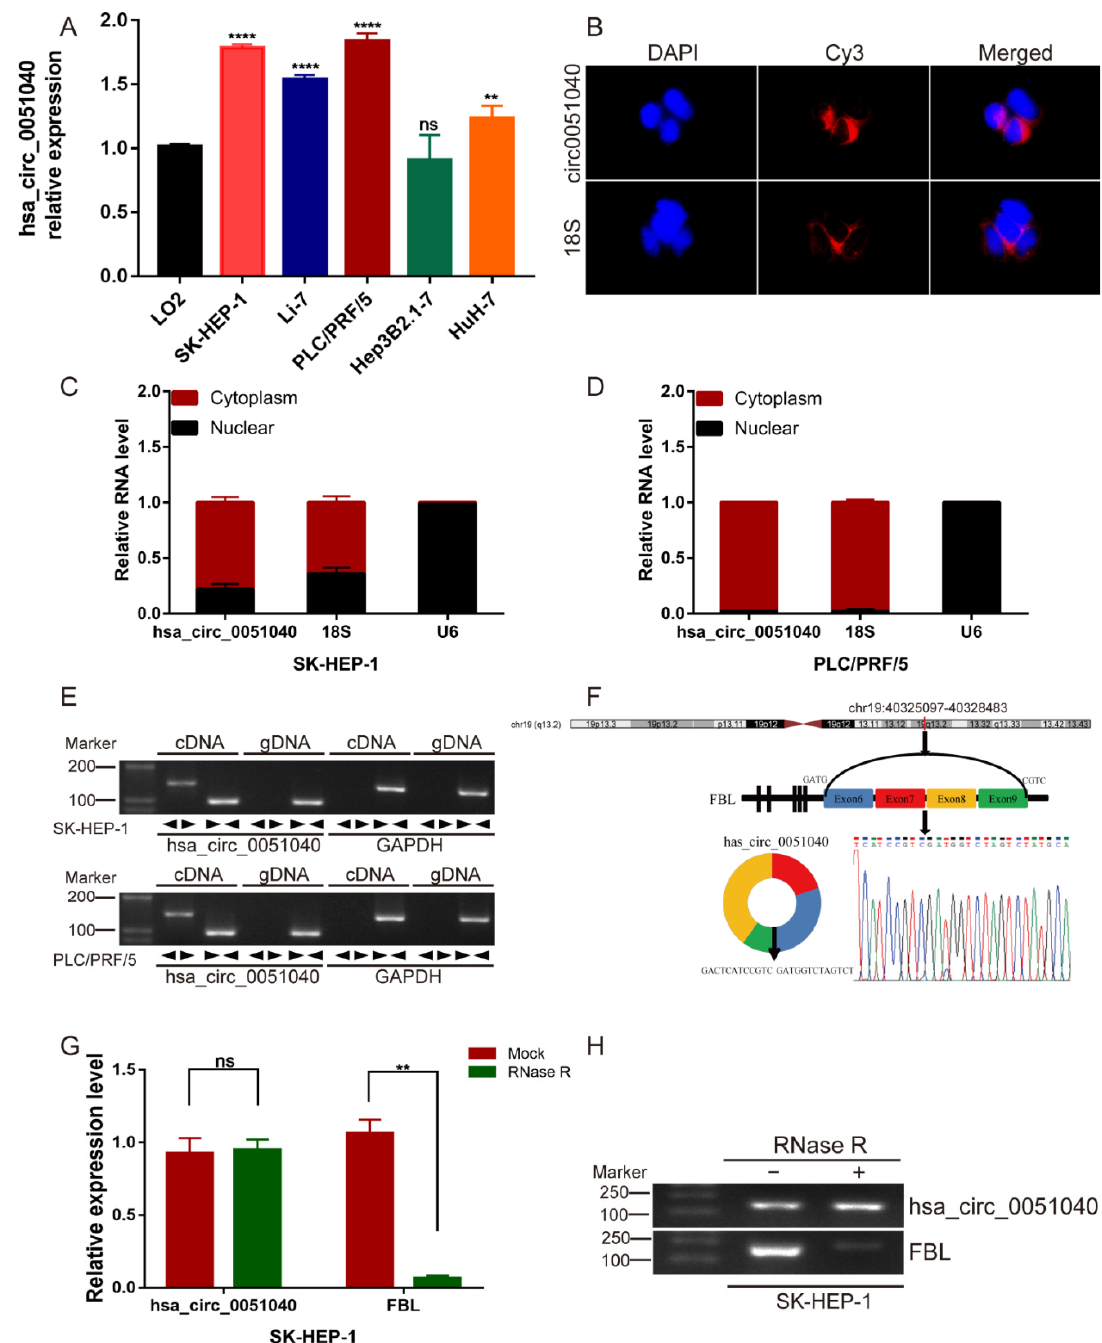
Figure 2. Identification and characteristics of hsa_circ_0051040 in HCC cells. ( A ) The expression levels of hsa_circ_0051040 were detected in HCC cell lines (SK-HEP-1, Li-7, PLC/PRF/5, Hep3B2.1-7 and HuH-7) compared to LO2 cells as control set as 1 by qRT-PCR. ( B ) FISH assay was used to detect the subcellular localization of hsa_circ_0051040 in HCC cells. hsa_circ_0051040 and 18S probe were labeled with Cy3. Nuclei were stained with DAPI. ( C , D ) qRT-PCR was used to measure the